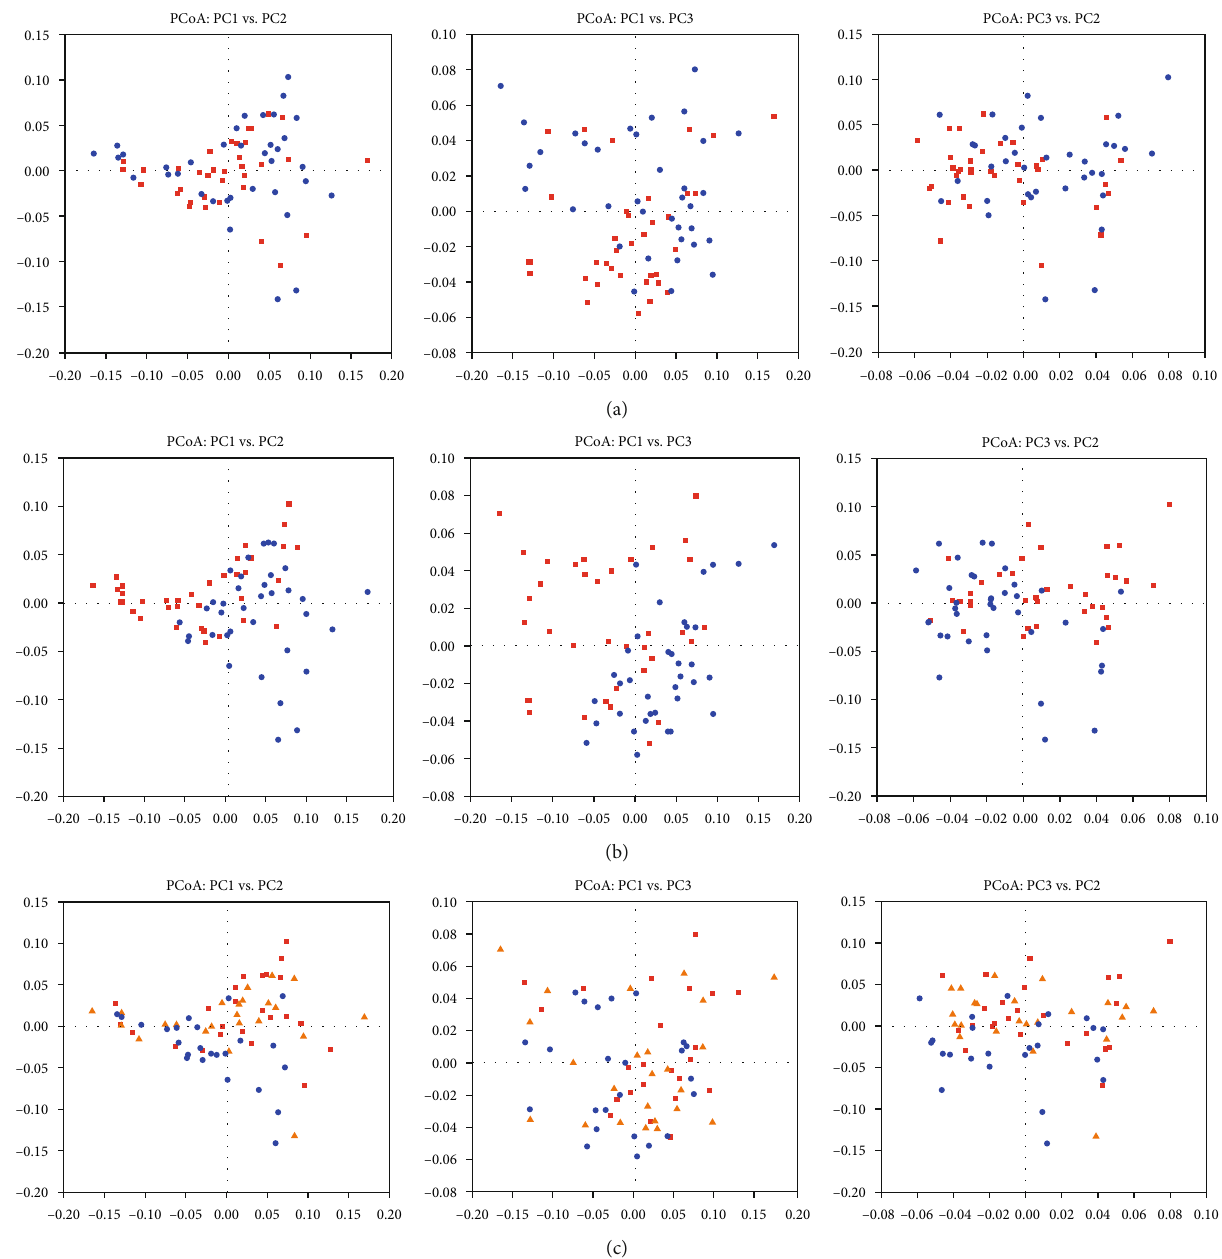
Figure 1: Principle coordinate analysis (PCoA) for beta-diversity of ruminal archaea in the liquid phase of the incubation content of fermenters, under the e ff ects of (a) temperature (red squares: 39.5 ° C; blue circles: 42 ° C), (b) osmolality 1 (blue circles: normal; red squares: osmotic stress), and (c) betaine supplementation 2 (red squares: control; orange triangles: low; blue circles: high). The fi rst 3 components were plotted and in total principle component explained 69.74% of the total variation ( PC1 = 43 : 07 , PC2 = 16 : 45 , and PC3 = 10 : 22 % , respectively). 1 Normal osmolality ~ 295 mOsmolkg − 1 ; hyperosmolality ~ 420 mOsmolkg − 1 . 2 Betaine levels: control (0), low (51), and high (286)